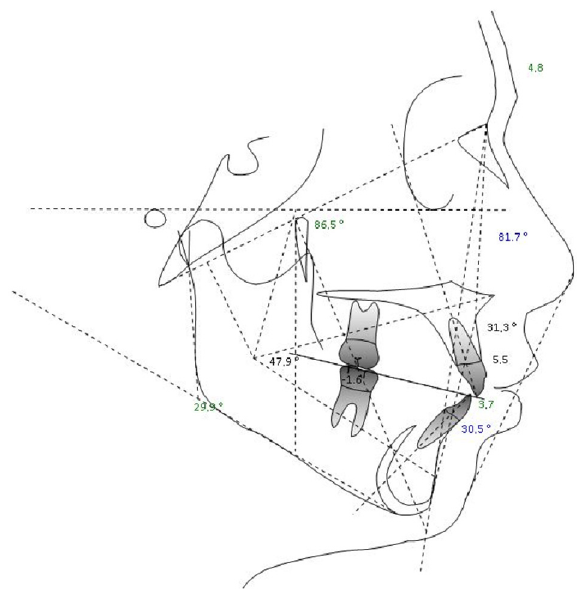
Figure 7. Cephalometric analysis. Table 4. Cephalometric analysis results.